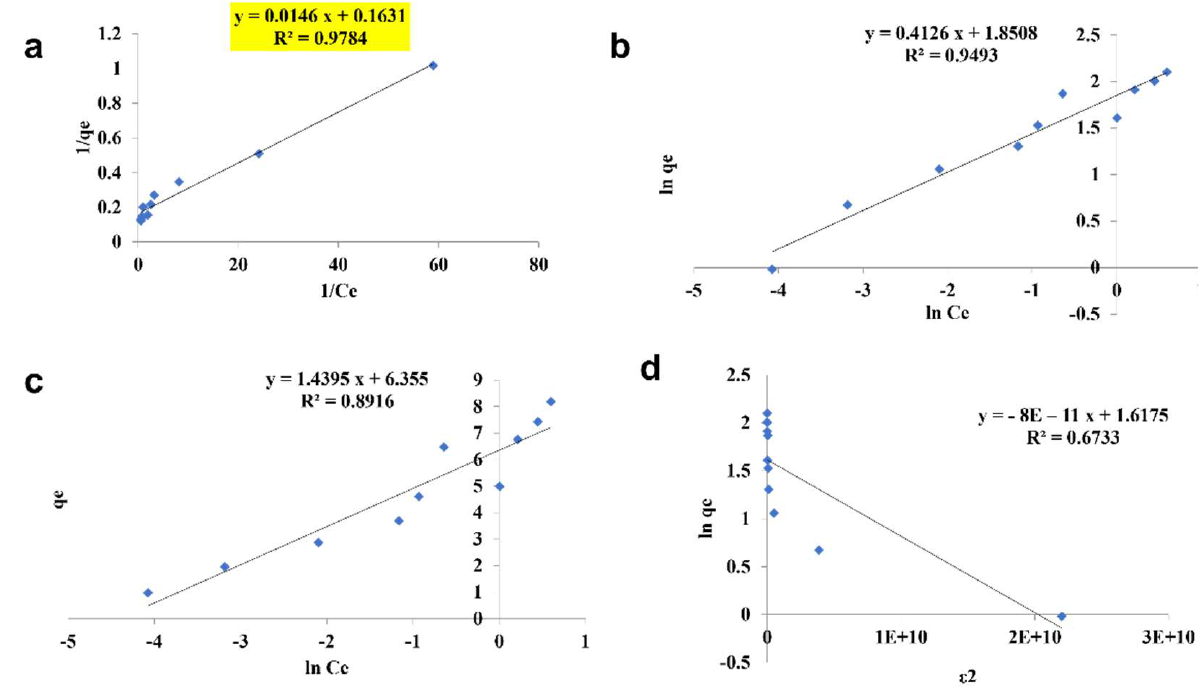
Figure 11. Isotherm study of alginate beads. ( a ) Langmuir Isotherm, ( b ) Freundlich Isotherm, ( c ) Tempkin Isotherm, ( d ) D—R Isotherm.